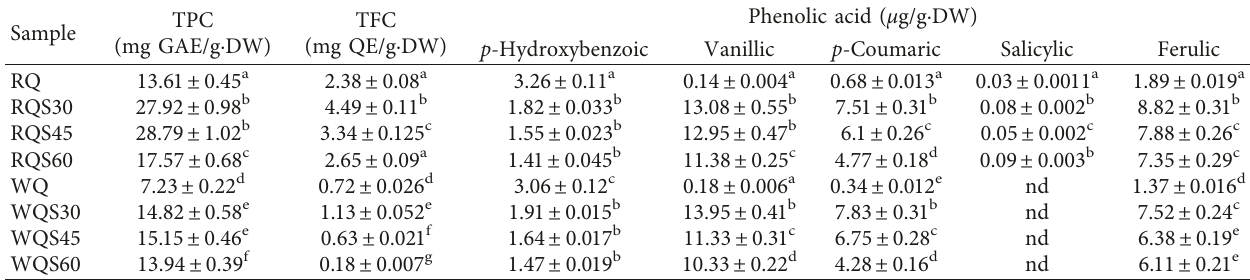
Table 1: Total phenolics content (TPC), total flavonoids content (TFC), and phenolic acids profile of red and white quinoa sprouts.